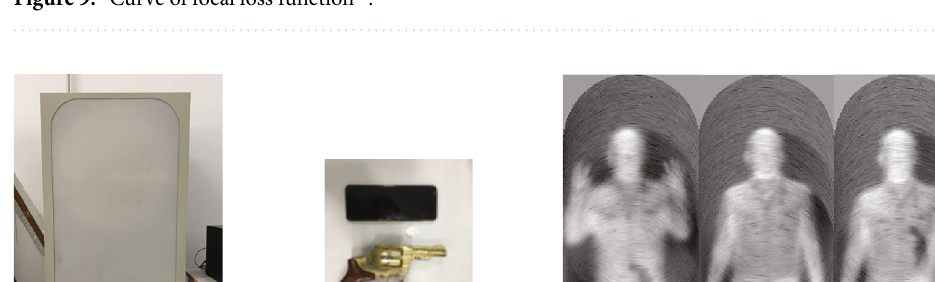
Figure 9. Curve of focal loss function 22 .